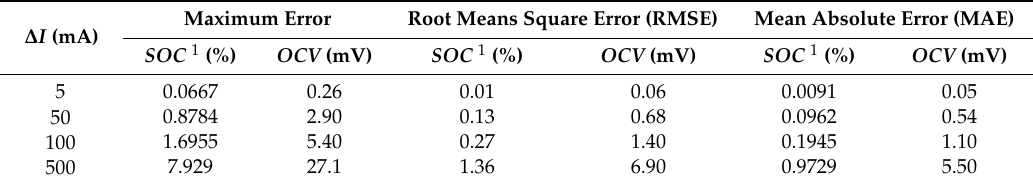
Table 4. Statistical error analysis at di ff erent values of current